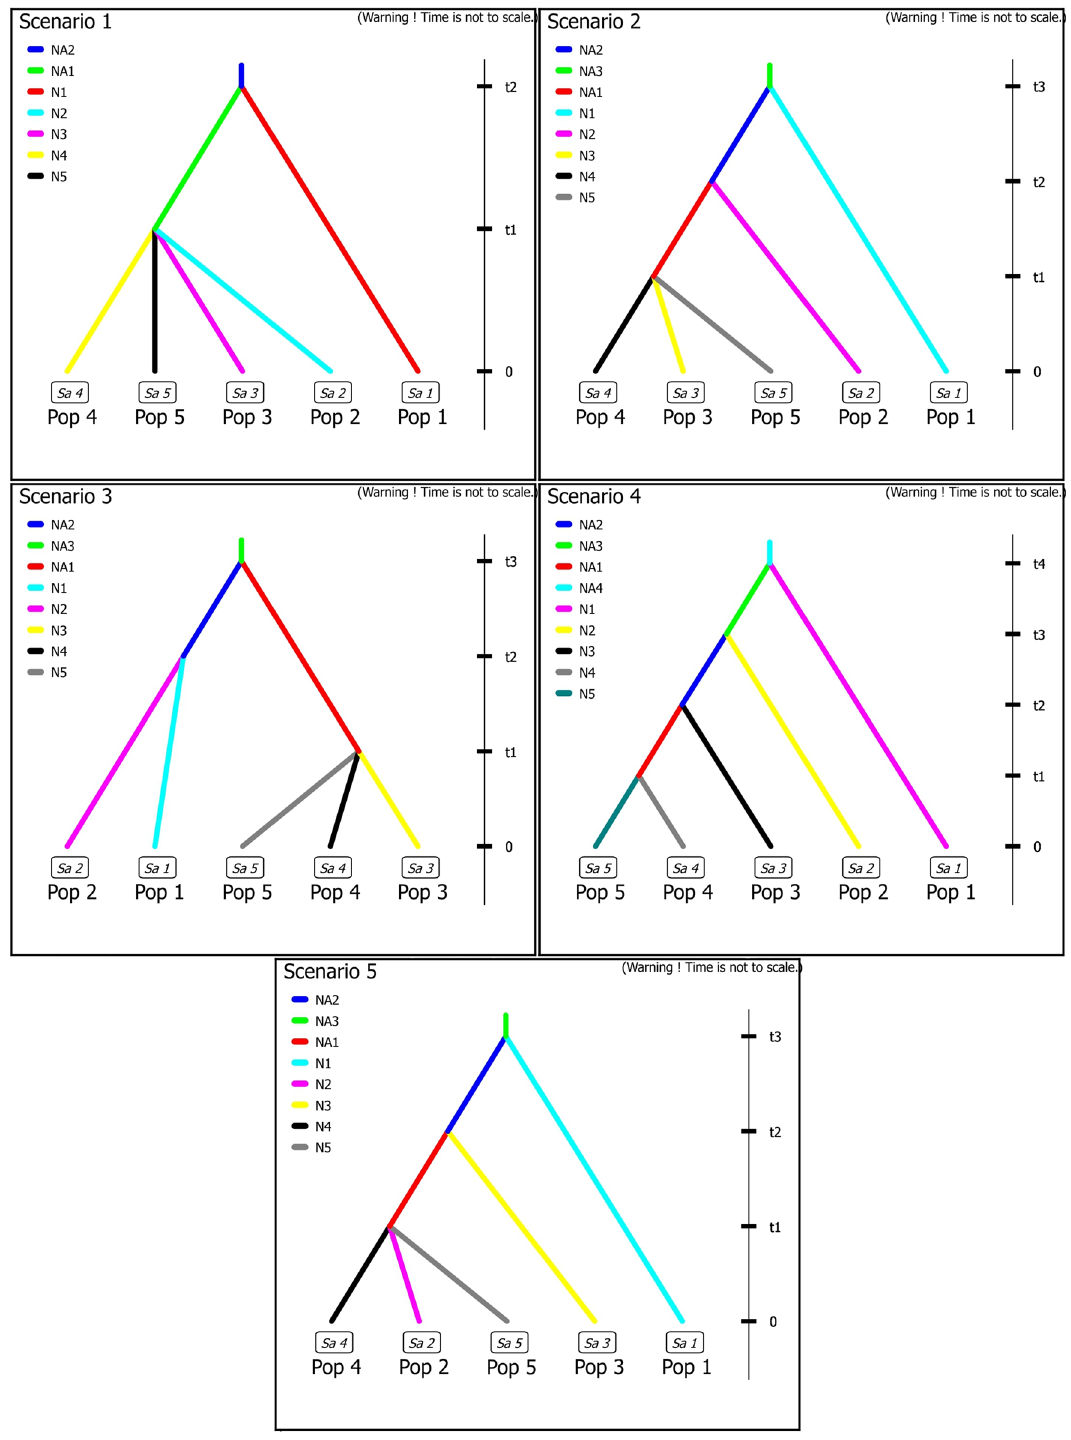
Figure 6. Graphical representation of tested historical scenarios of divergence among ancestral common sage ( Salvia officinalis L.) populations in the Apennine and Balkan Peninsula using approximate Bayesian computation. t1–t4—times of past divergence events in terms of the number of generations, N1–N5 and NA1– NA4—effective population size during the given time period. Pop1–Pop5 correspond to SAp, CAp, NBalk, CBalk and SBalk,